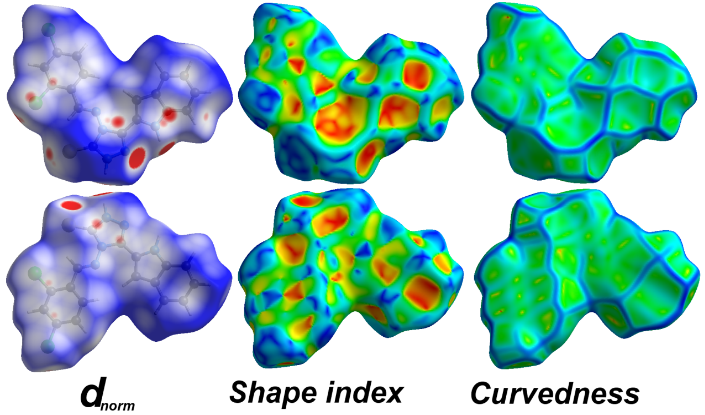
Figure 7. Hirshfeld surfaces of 4 .